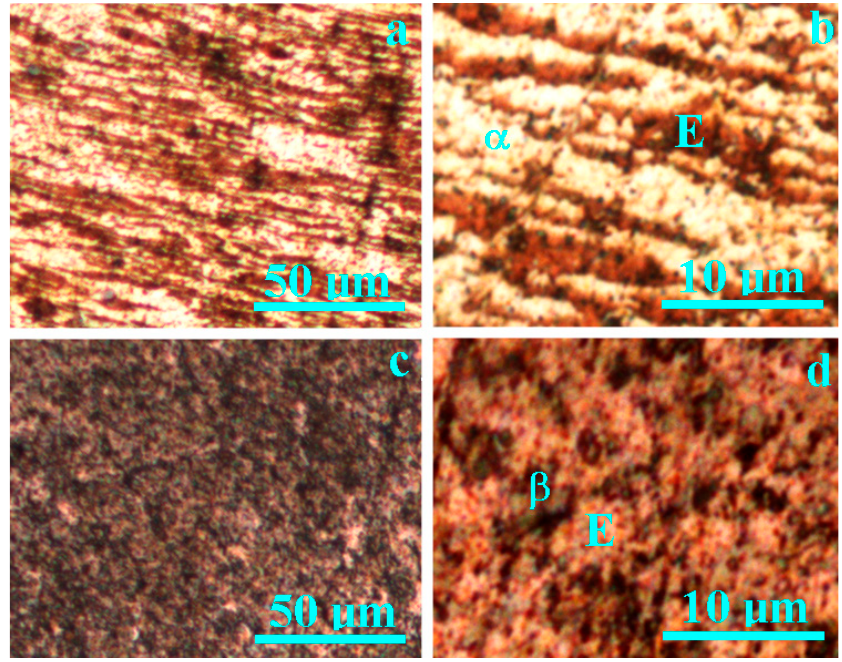
Figure 3. Metallographic microstructures of 3-Polker coin issued in 1619: ( a ) general view and ( b ) microstructure detail and of coin issued in 1625: ( c ) general view and ( d ) microstructure detail, where: E—eutectic, α —silver phase, and β —copper phase.